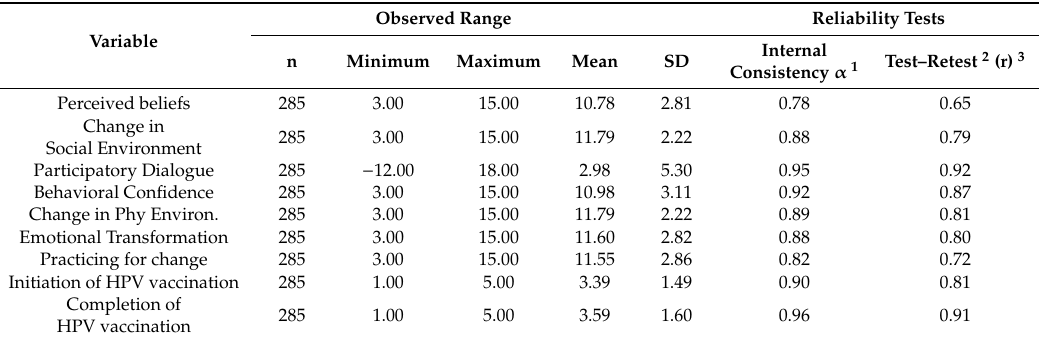
Table 2. Distribution of range, means, and standard deviation of independent and reliability test for the variables and outcome variables ( n =